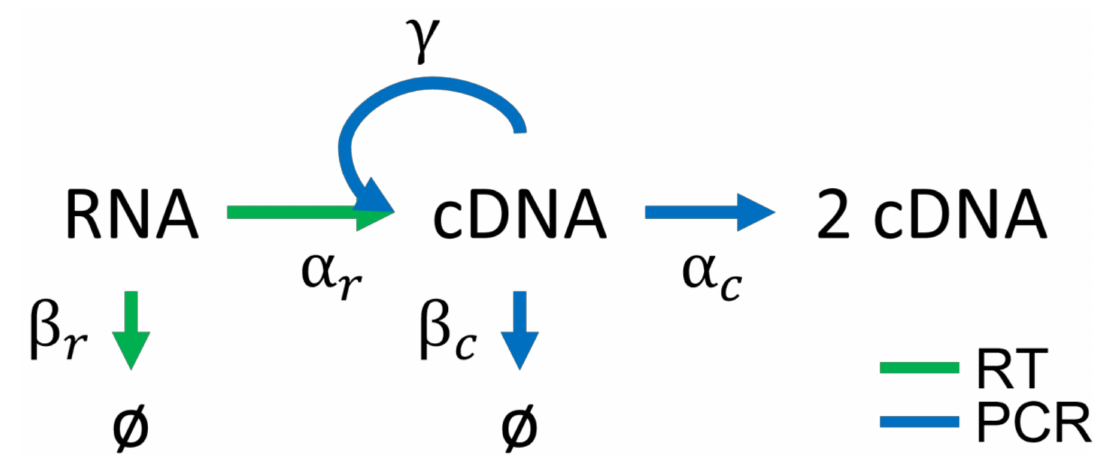
Figure 1. RT-PCR model. Representation of the complete RT-PCR process that was split into two subprocesses. Green and blue arrows denote the RT and the PCR processes,